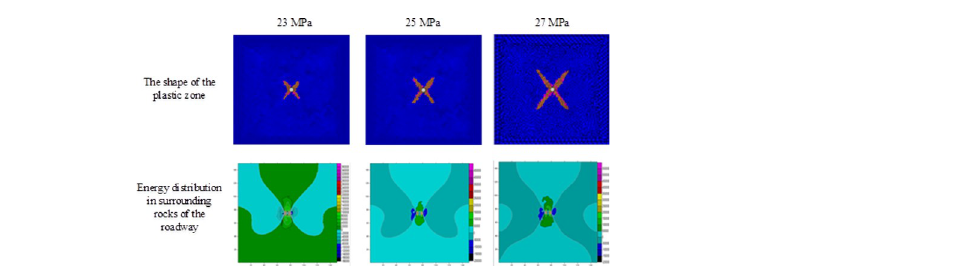
Fig 6. The shape of the plastic zone and the energy distribution of the surrounding rock of the roadway under the abutment pressure of 23~27MPa.